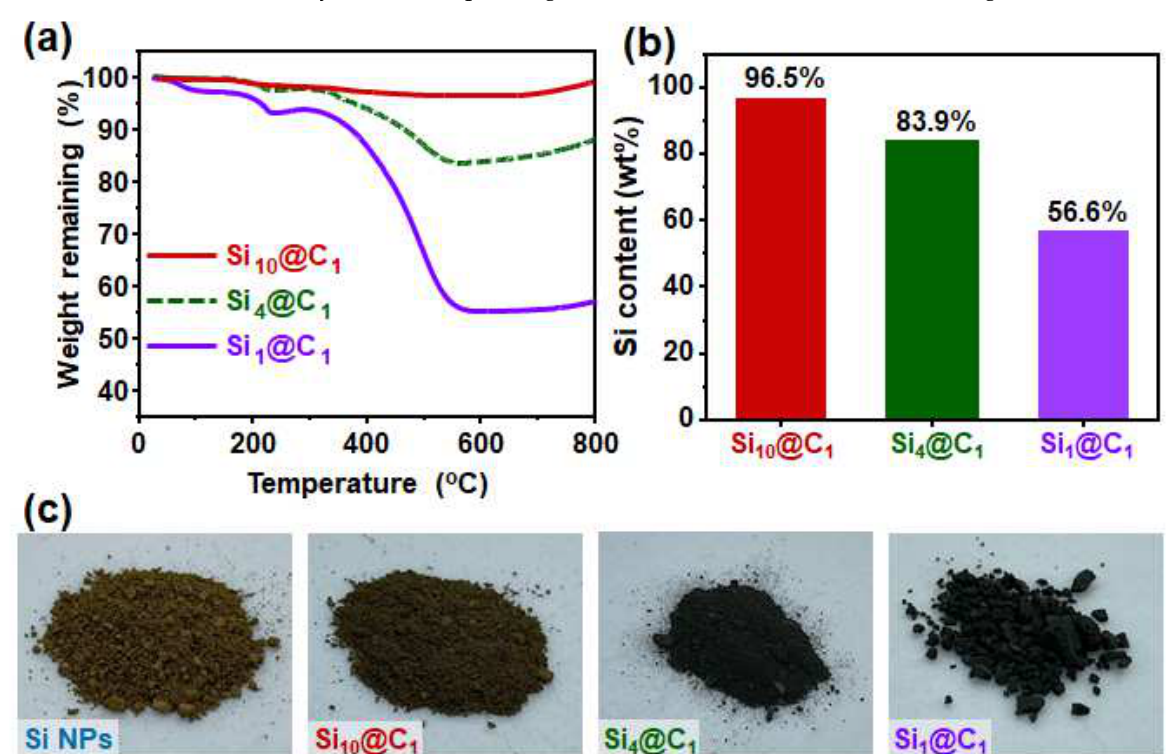
Figure 3. ( a ) TGA curves of Si@C NPs derived from various ratios of Si NPs and phenolic resin; ( b